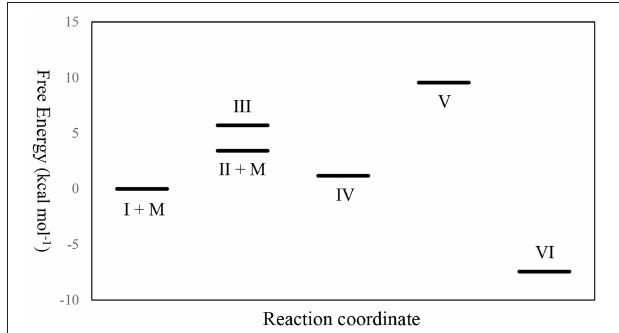
FIGURE 12 | The relative free energy level diagram of all intermediates in the mechanism. M stands for methanol.